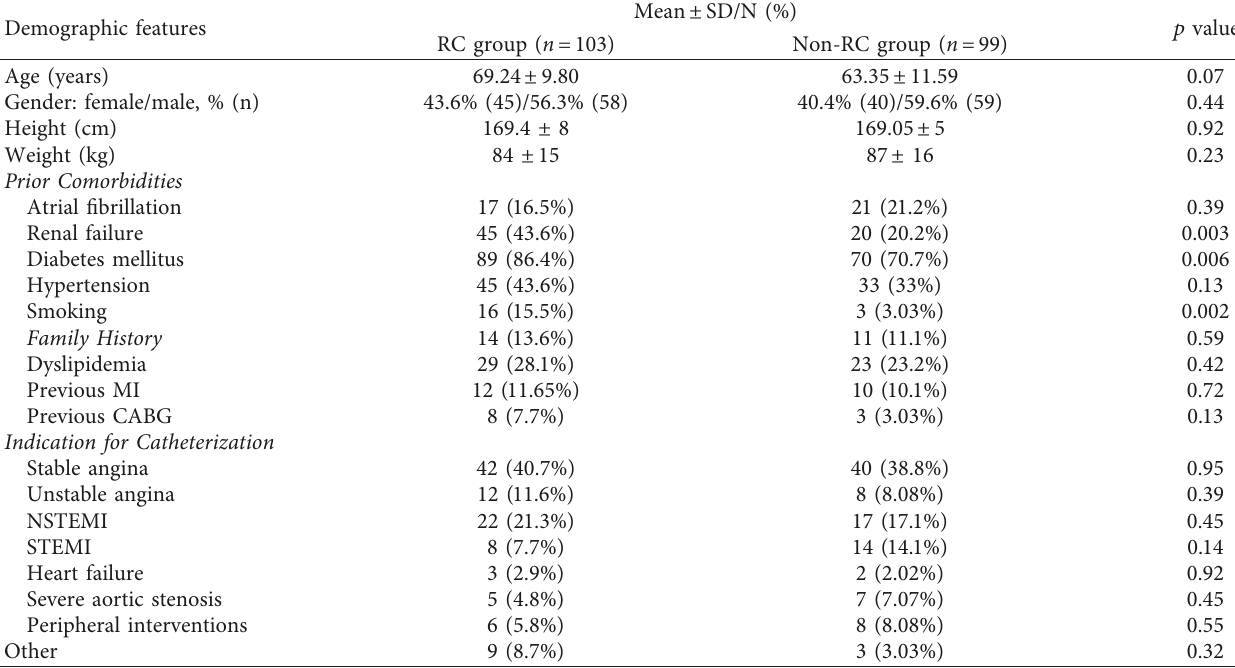
Table 1: Baseline characteristics of all 202